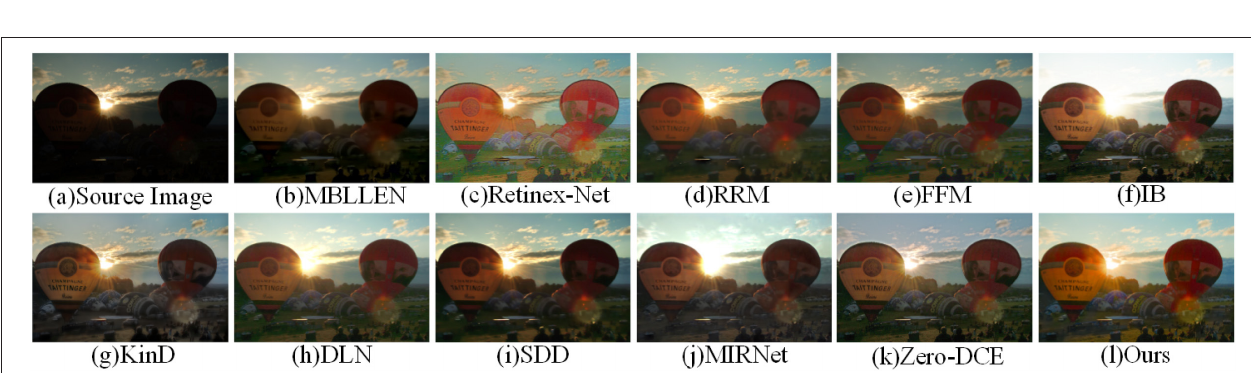
FIGURE 10 | Comparison of the visual effects of our method and other low-light enhancement methods in the MEF dataset. (A) is the original image, (B–K) is the other 10 low-light enhancement methods, and (I) is our method.